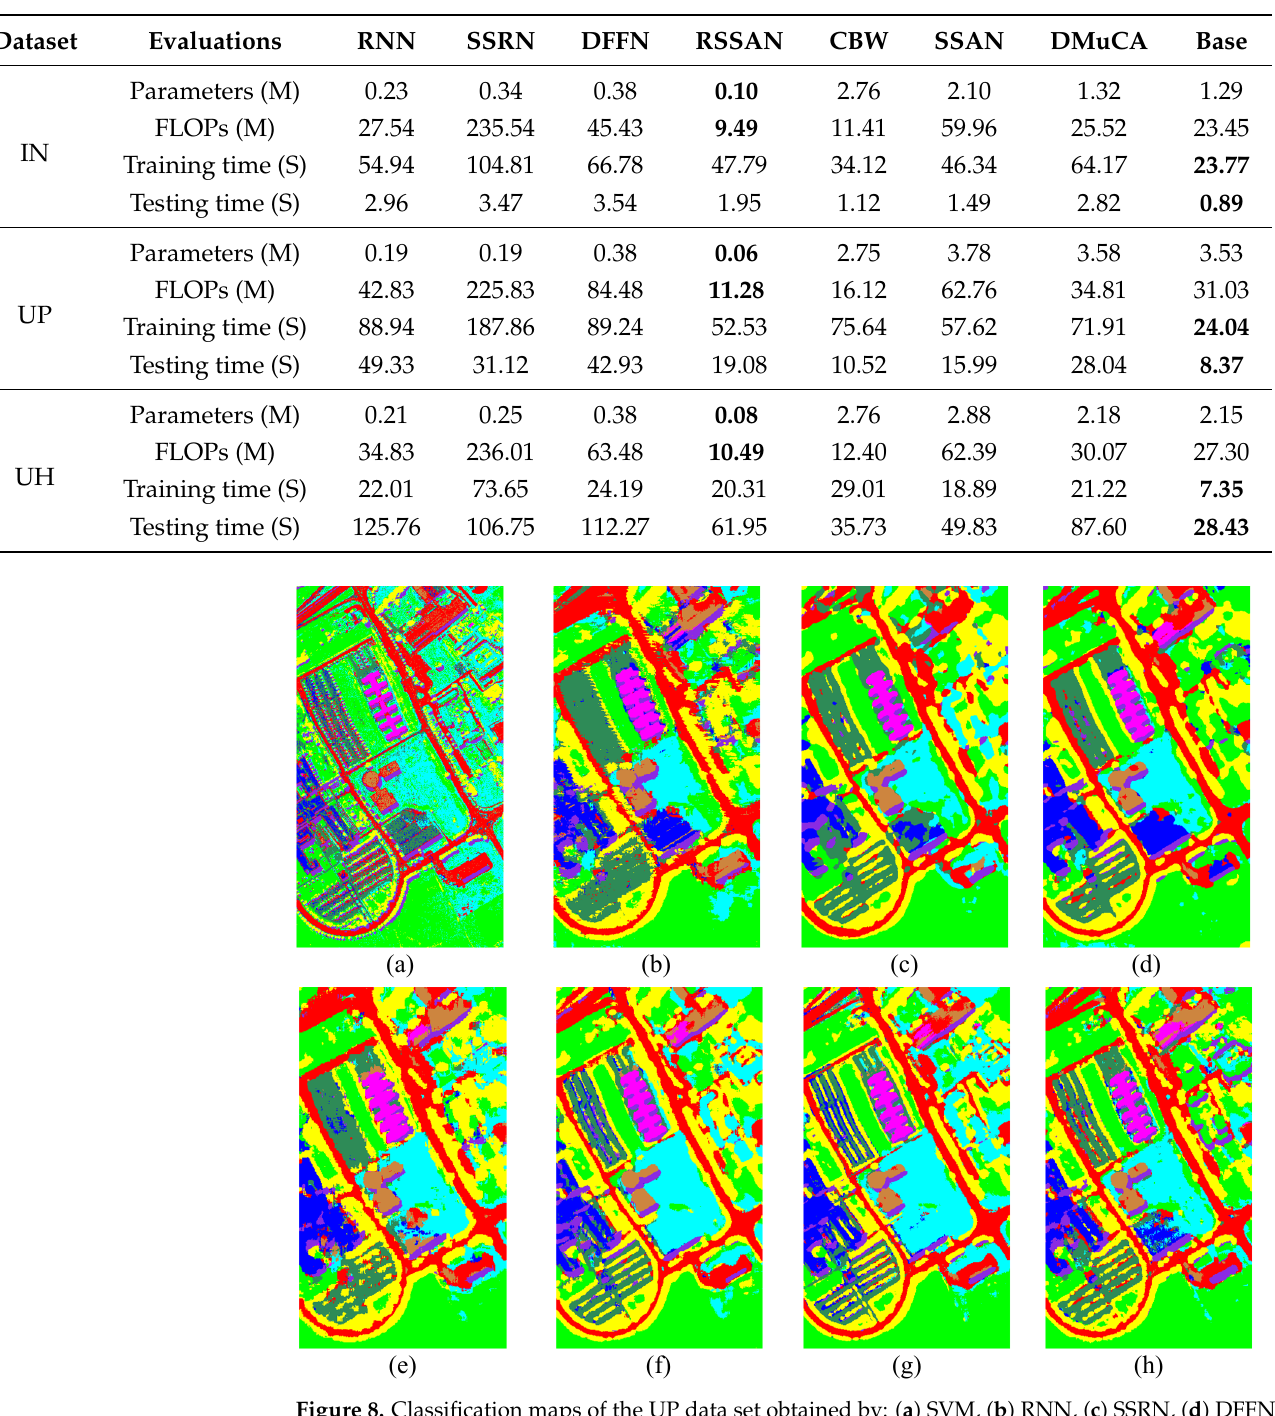
Figure 8. Classification maps of the UP data set obtained by: ( a ) SVM, ( b ) RNN, ( c ) SSRN, ( d )